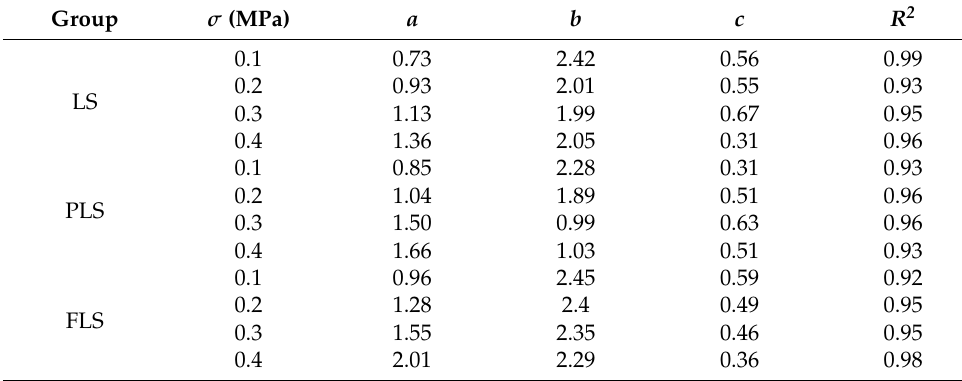
Table 7. Fitting results of CSE